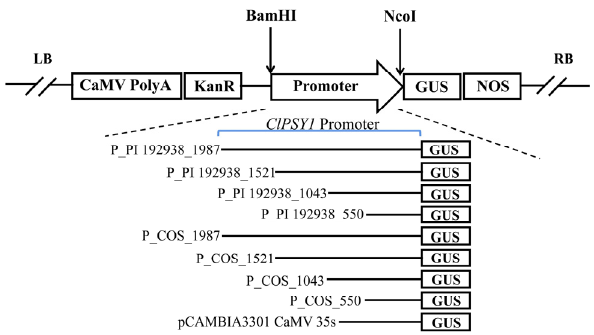
Figure 2. Schematic representation of the ClPsy1 promoter: GUS vectors construction. These constructs are based on the pCAMBIA3301 vector. LB, the vector left border; CaMV polyA, Cauliflower mosaic virus 35S terminator; KanR , kanamycin resistance gene; GUS , β‐ glucuronidase reporter gene; Nos, nopaline synthase terminator; RB, the vector right border. Hollow arrows indicate the positions of the promoter insertion in the vectors. Promoters contain the full ‐ length sequence and its truncated fragments.